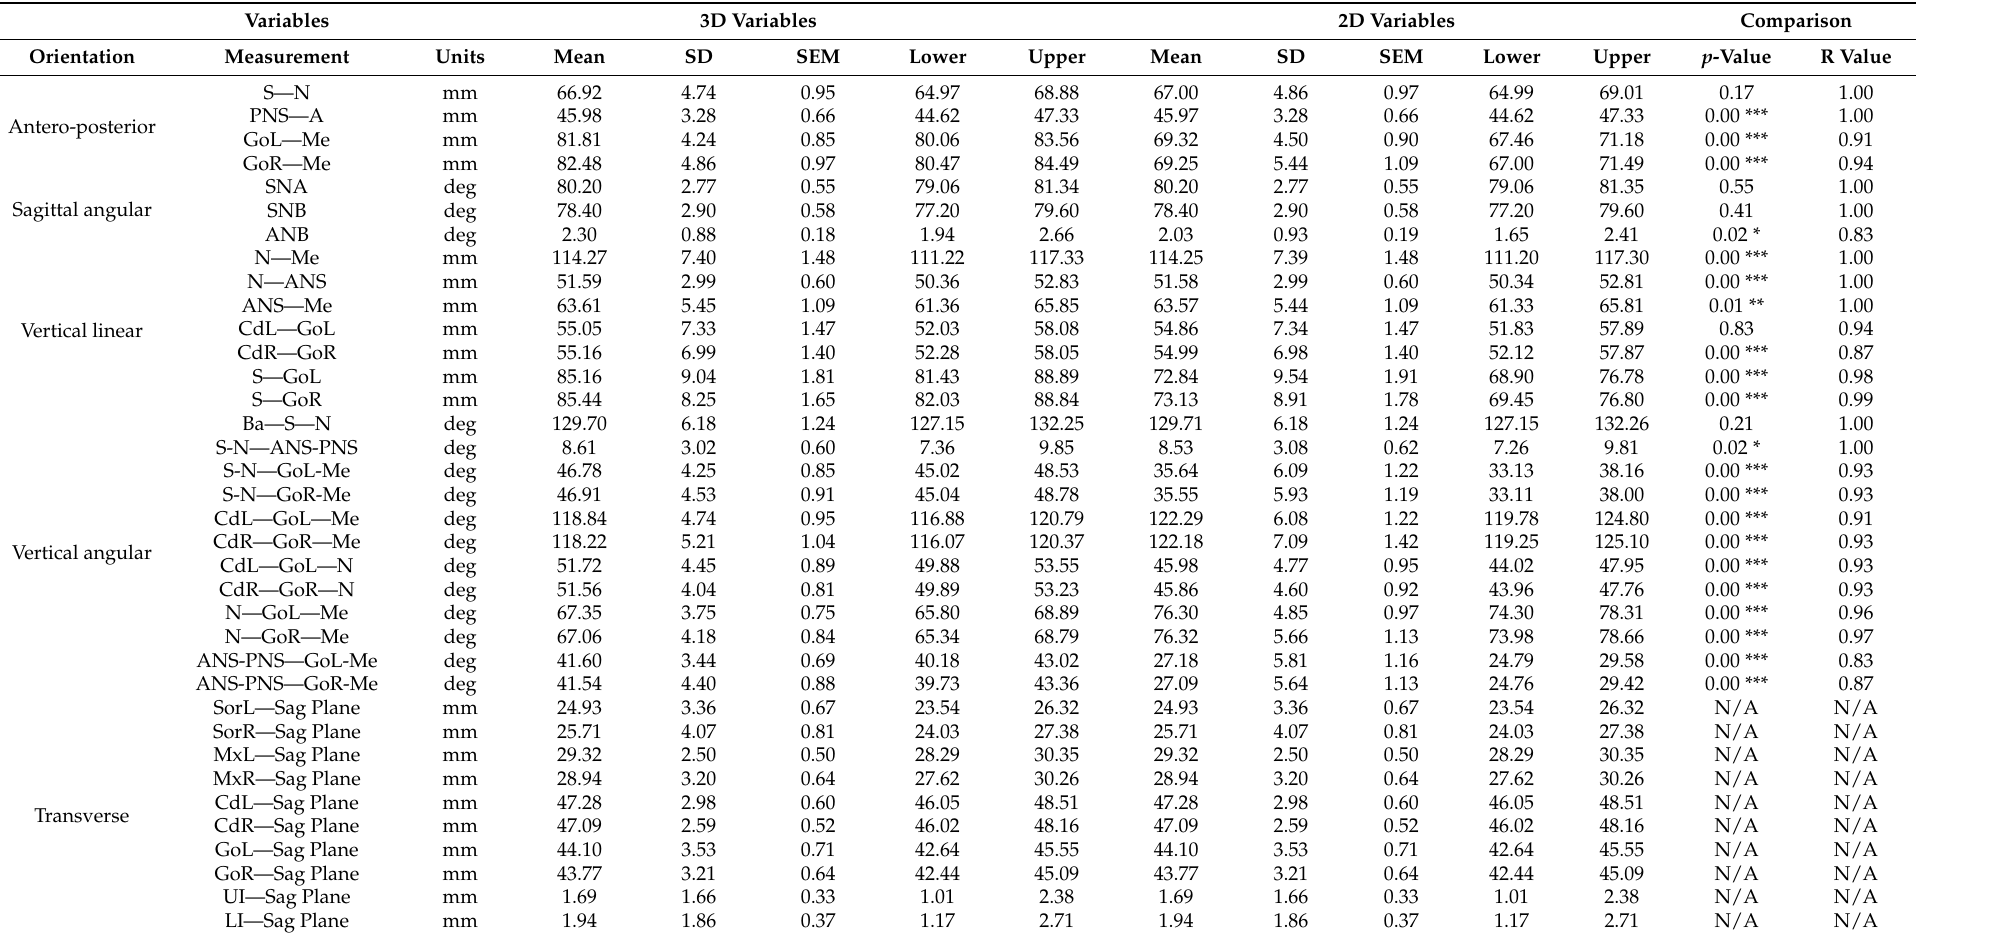
Table 4. Descriptive statistics (mean, standard deviation (SD), SEM, and 95% confidence interval (CI) lower and higher) of the 3D and 2D cephalometric measurements and their comparisons (Pearson correlation coefficient R and p -value) for the post-peak age subgroup. Confidence interval (CI), lower (L), upper (U) limits; p -values and relevant correlation coefficients are computed by the Pearson correlation analysis; not computed (n/a) statistical significance